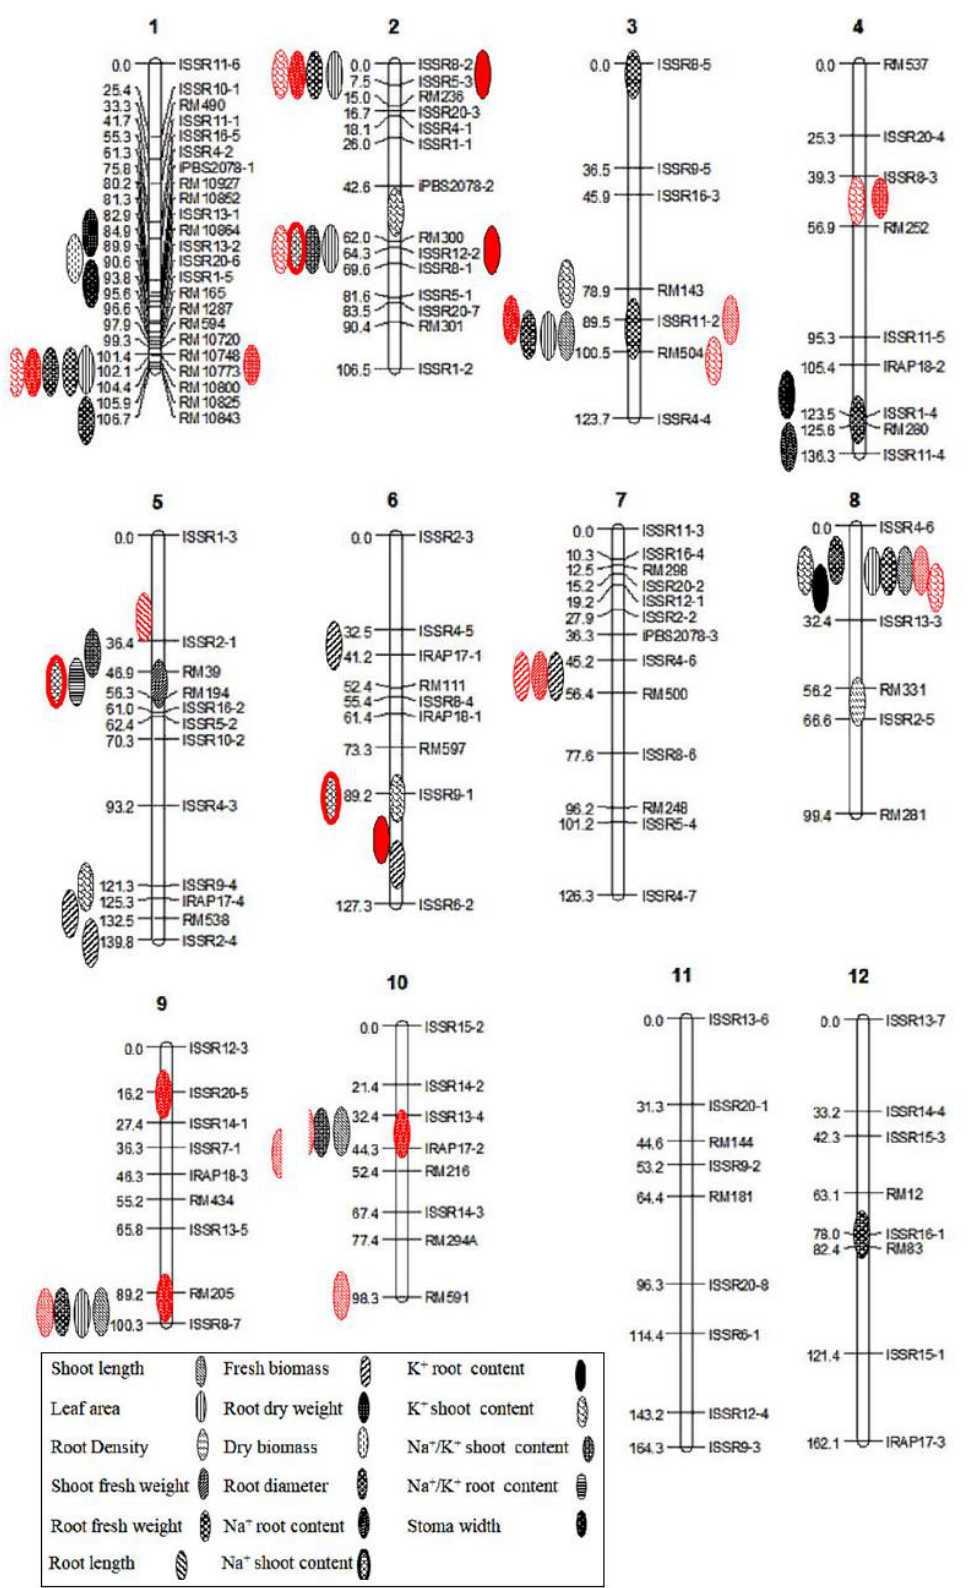
Fig. 1. Genetic linkage maps QTLs identified under normal and salt stress conditions of the in the seedling stage the F 8 population derived from ATM × NAD: Red are the same under salt stress